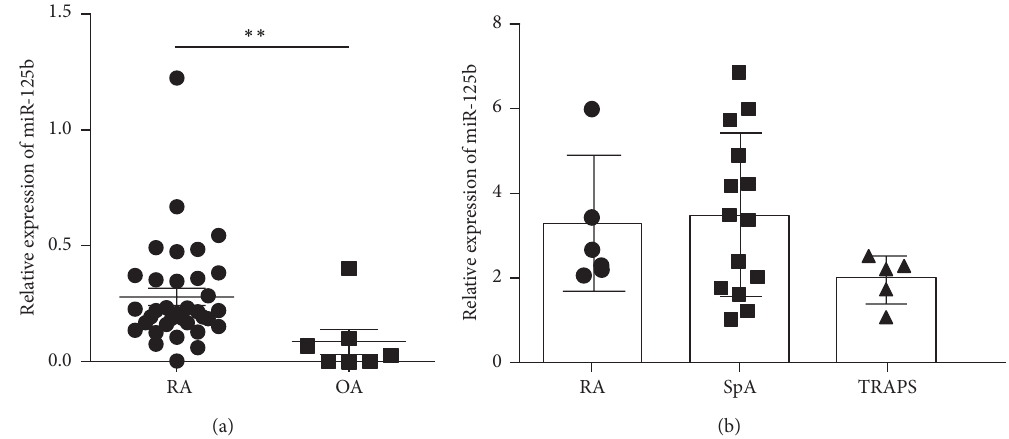
Figure 2: Serum levels of miR-125b in various rheumatic diseases. (a) Serum levels of mature miR-125b in patients with rheumatoid arthritis (RA, 𝑛 = 32 ) or osteoarthritis (OA, 𝑛 = 7 ). (b) Serum levels of miR-125b in patients with tumor necrosis factor receptor periodic syndrome (TRAPS), spondyloarthropathies (SpA), and rheumatoid arthritis (RA). miR-125b was quantified by RT-qPCR as described in M&M ( 𝑛 = 5 – 15/group). ∗∗ 𝑃 < 0.01 as determined by Mann-Whitney test.